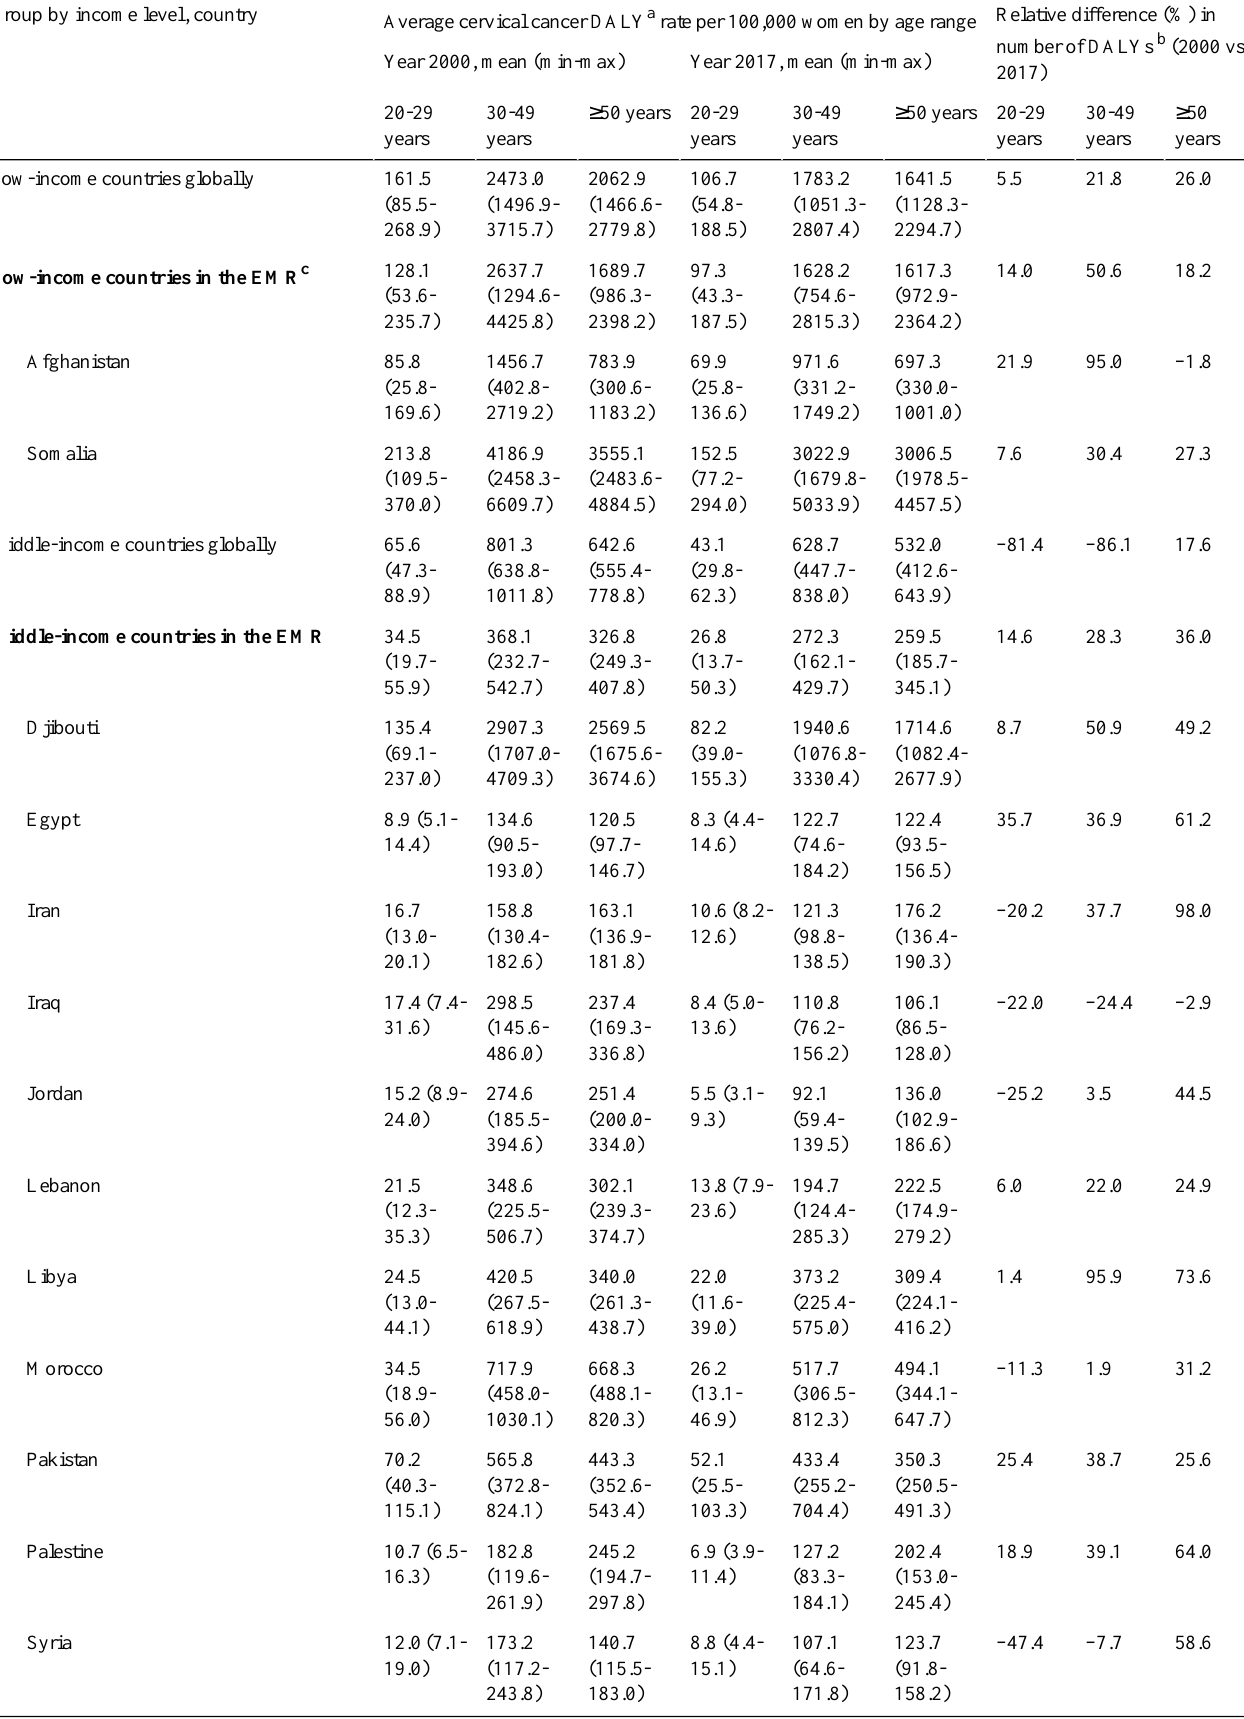
Table 4. Disability-adjusted life years data due to cervical cancer among women older than 20 years in the Eastern Mediterranean Region by age, country, and income level compared to the global average in the years 2000 and